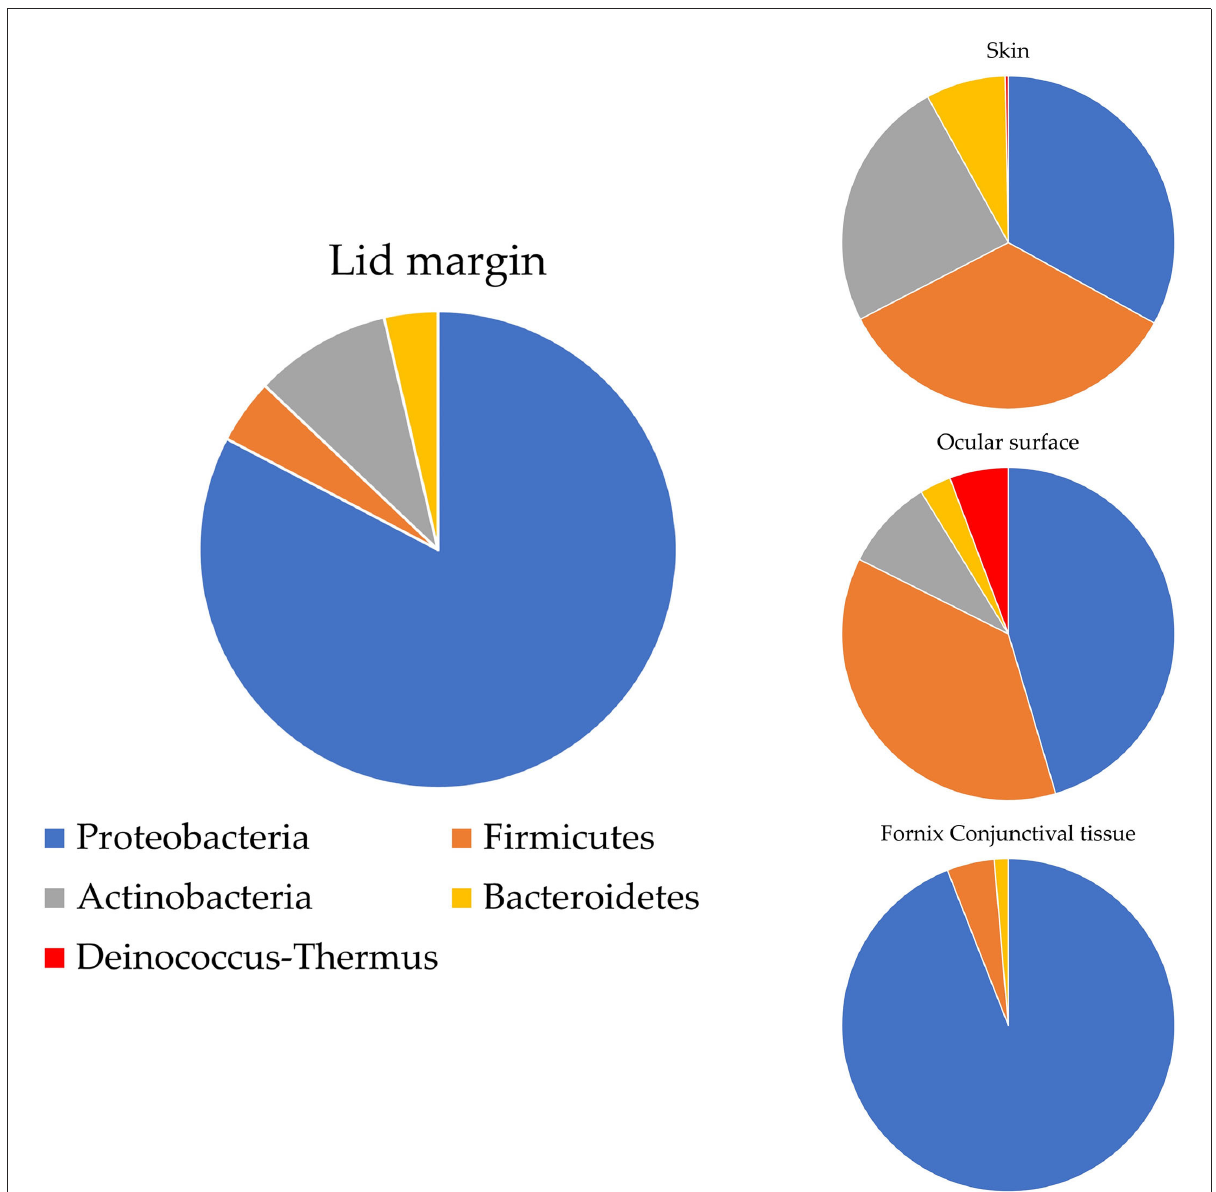
FIGURE1 OSM distribution on ocular surface by Ozkan et al. (2019). Proteobacteria account for most of the ocular flora in most areas, while the periocular skin flora is predominated by Firmicutes and colonized with Actinobacteria more frequently than other